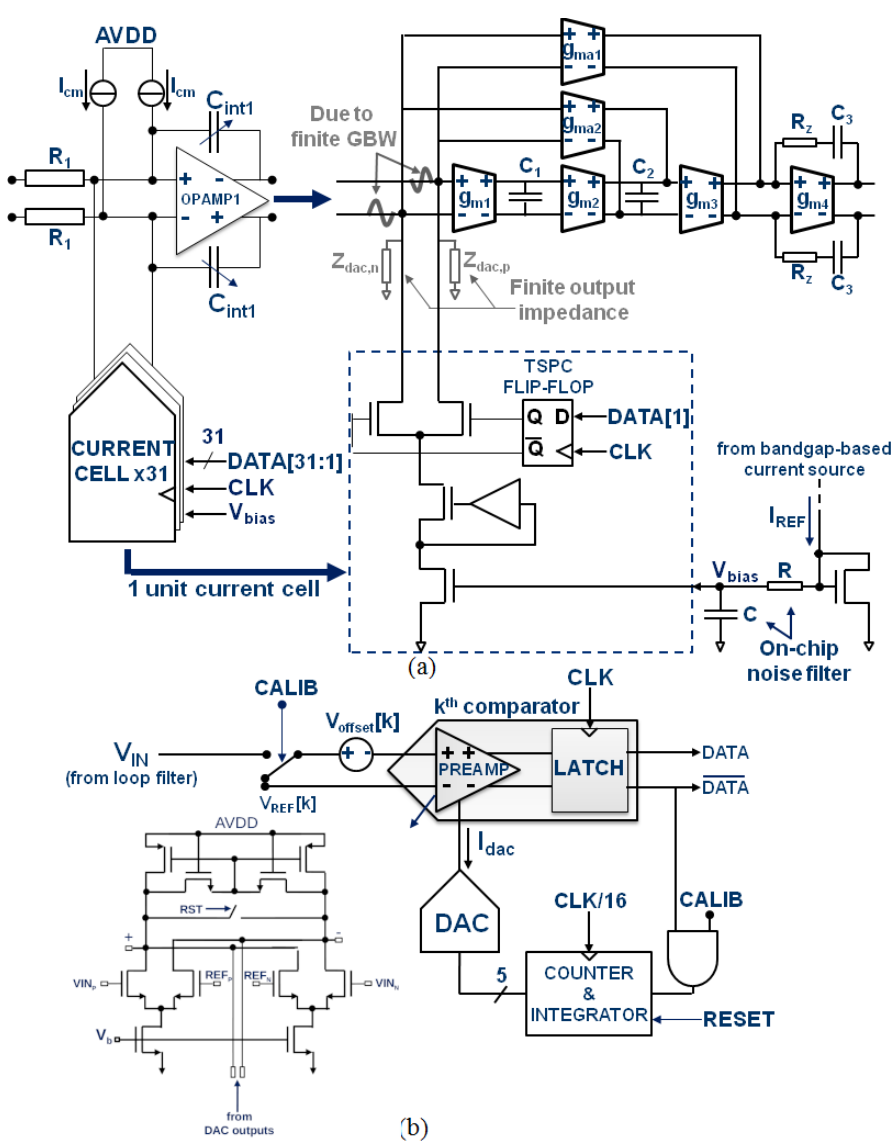
Figure 8. Schematic of ( a ) the ∆Σ modulator front-end, ( b ) one comparator